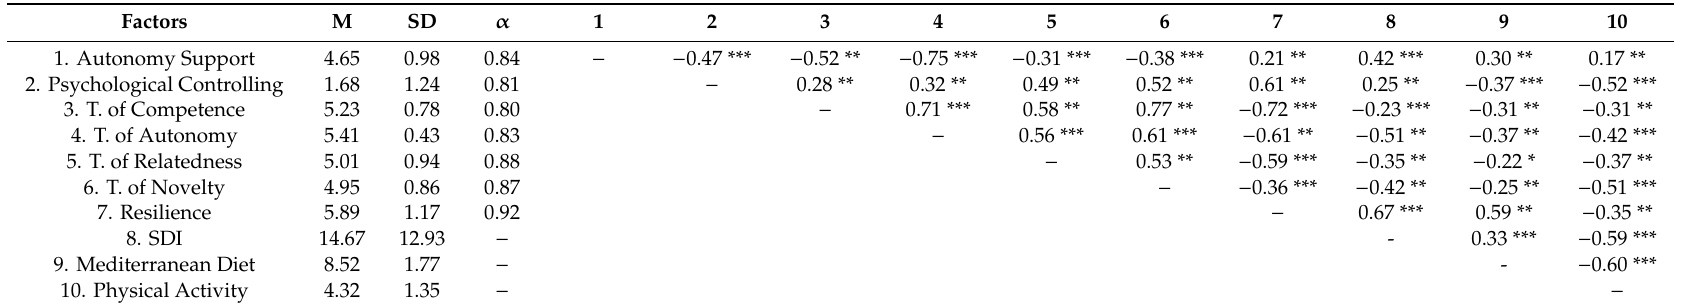
Table 1. Preliminary analyses and